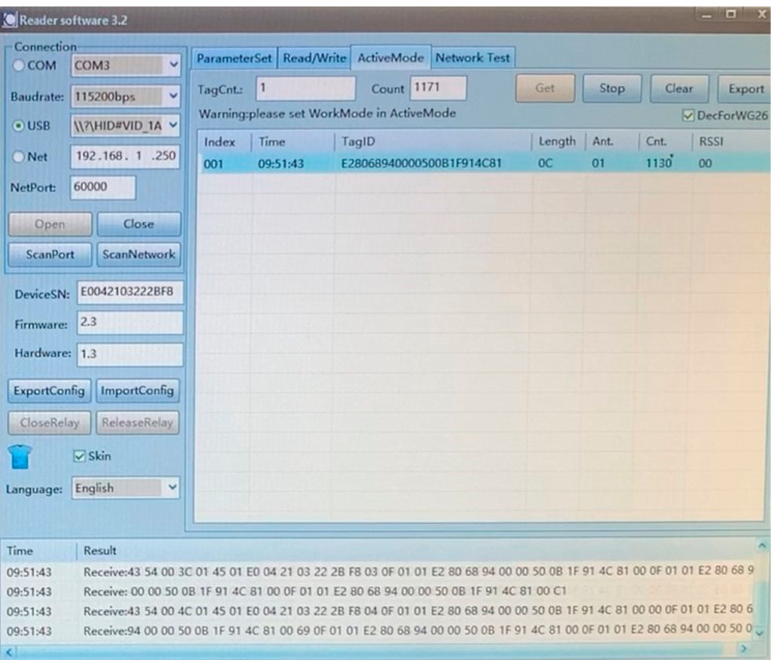
Figure 9. Image taken from recorded footage of communication monitoring between the tag antenna and reader in the Reader Software environment.